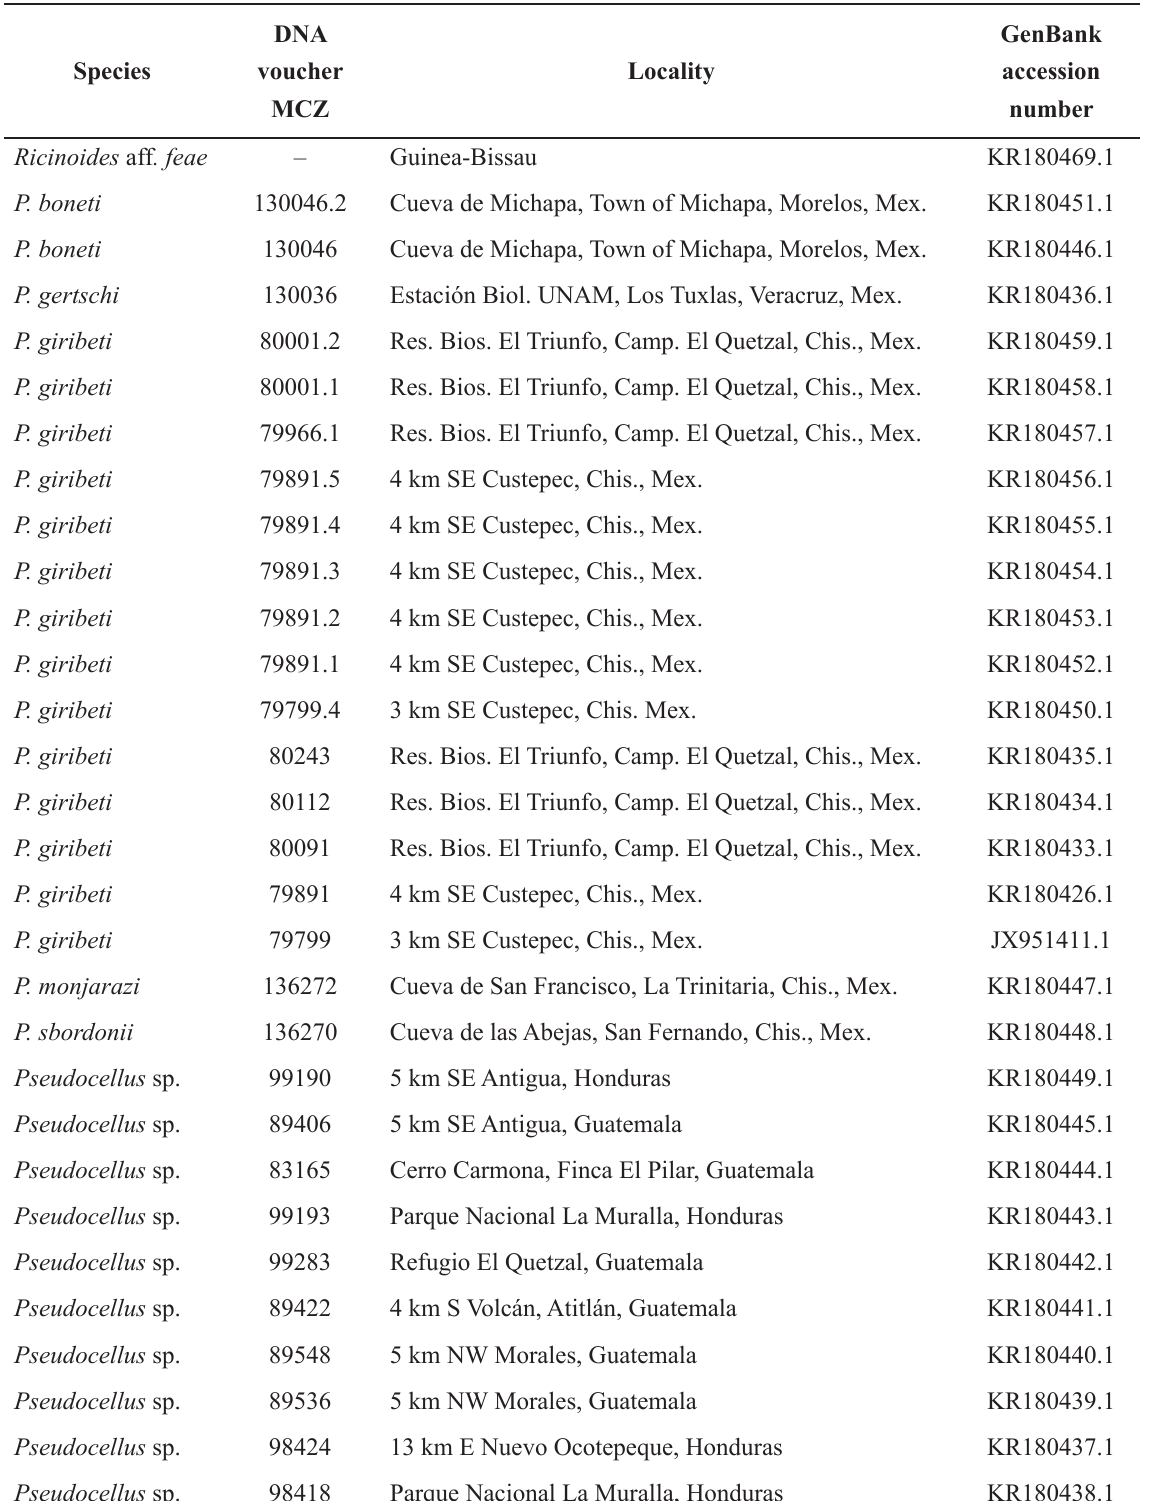
Table 1. Samples of Pseudocellus Platnick, 1980 used for molecular analyses, DNA voucher numbers, localities, and GenBank accession numbers for